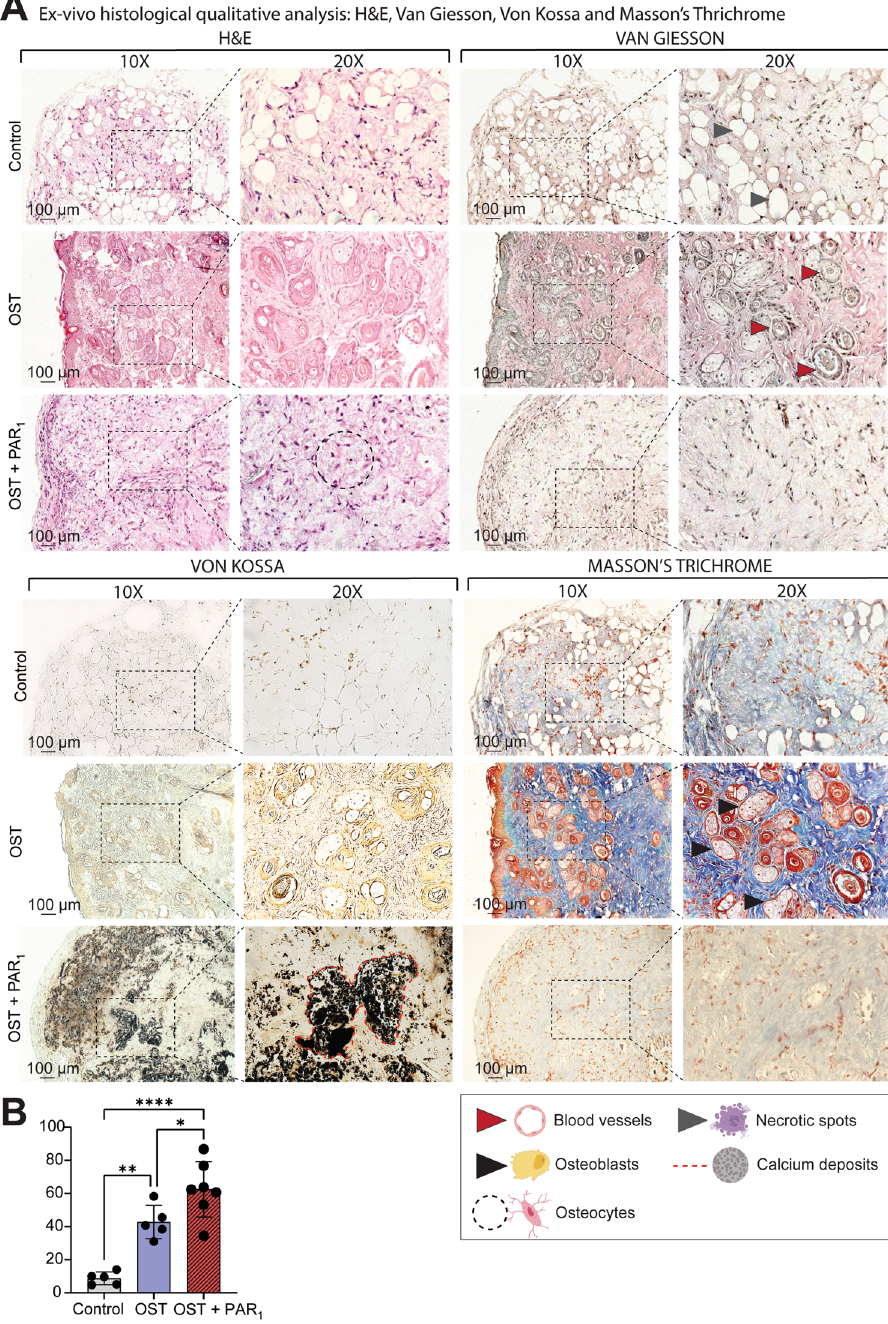
Figure 4. ( A ) Ex-vivo histological qualitative analysis from H&E, Van Gieson, Masson’s Trichrome and Von Kossa stains from the 3 groups after a 2-month transplantation period in balb/c nude mice. Images at 10x and 20x. CTRL group displayed connective tissue characteristics with necrotic spots (gray arrows) and no bone formation was detected in this group for the 4 stains. Osteoblast clusters (black solid arrows) and blood vessels (red solid arrows) were detected in higher abundance in the OST group when compared with the other groups. The OST + PAR 1 group showed greater osteocyte numbers (black dotted circle) and higher calcium deposits ( B ) (red dotted